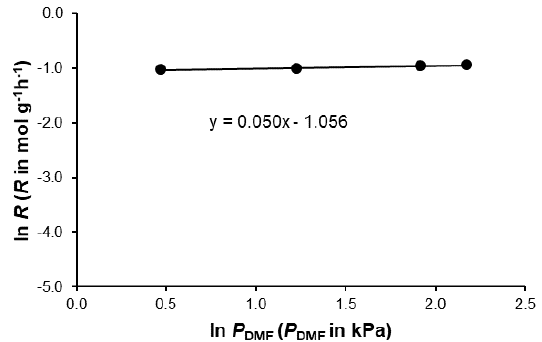
Figure 4. Effect of DMF partial pressure on the rate of DMF hydroconversion over 9.6%Pt/C + SiO₂ catalyst (0.10 g total weight, 1.3 mg Pt / C) at 70 ◦ C, 40 mL min − 1 H 2 flow rate.